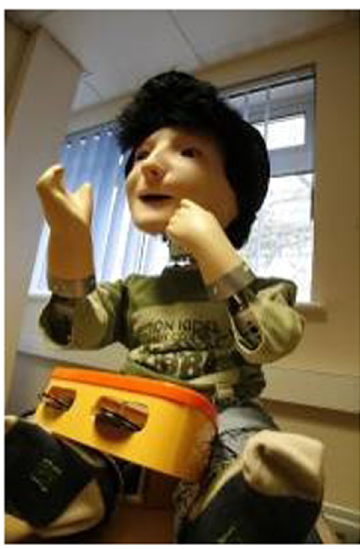
Figure 1: The Kaspar robot.